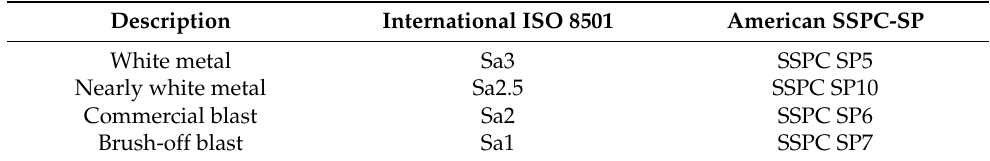
Table 2. Visual standards for grades of cleanliness.